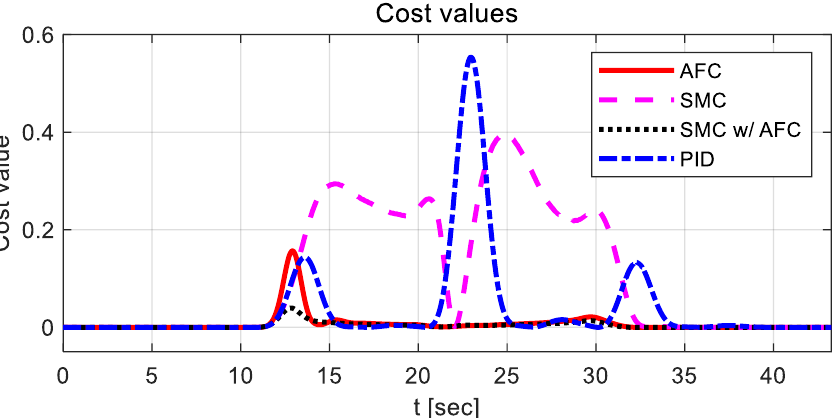
Figure 11. Results: cost value comparison for the curved path tracking.